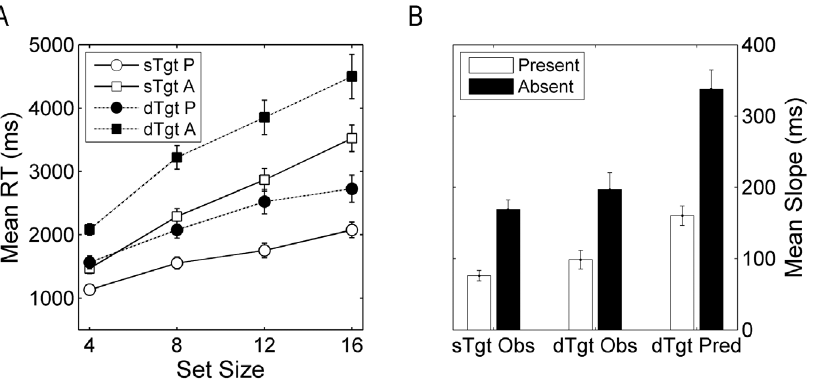
Figure 3. Mean RT by trial type and set size on single- and dual-target searches (a) and Mean observed RT-by-set-size slopes on single- (sTgtObs) and dual-target (dTgt Obs) searches and predicted RT-by-set-size slopes (dTgt Pred) for two consecutive single- target searches (b). Error bars denote standard errors of the means.